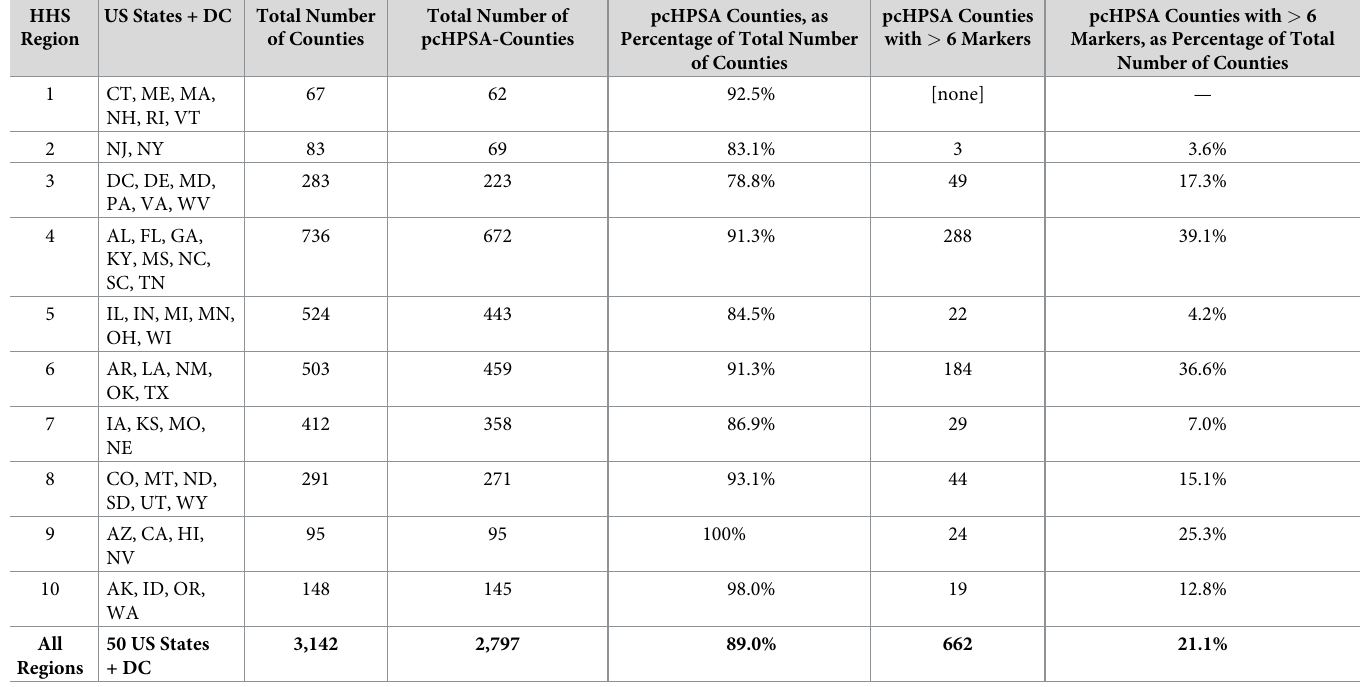
Table 2. Summary of pcHPSA counties, by HHS Region,